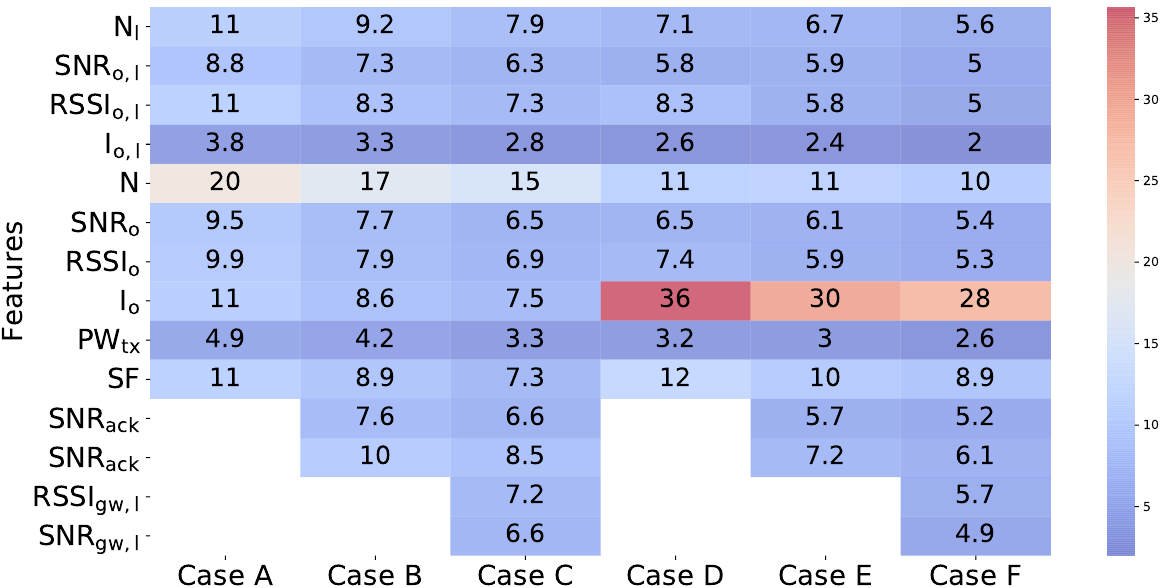
Figure 8. Feature importance obtained from Random Forest for the different cases